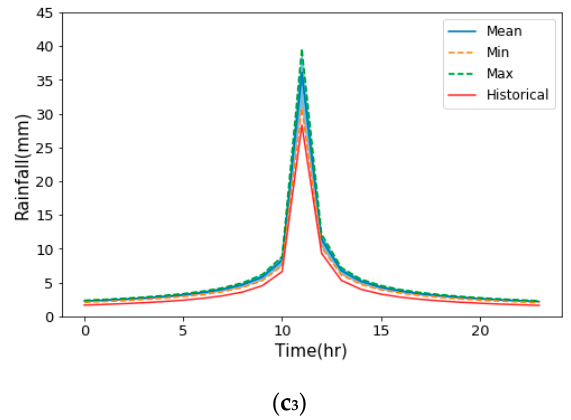
Figure 5. Rainfall hyetographs corresponding to a 25-year event for the historical and future (2050s, RCP4.5) periods. Hyetographs are generated based on ( a 1 ) HUFF, ( b 1 ) SCS, and ( c 1 ) ABM design storm methods for GCM-IDFs, and ( a 2 ) SCS, ( b 2 ) HUFF, ( c 2 ) ABM-1, and ( c 3 ) ABM-2 for WRF-IDFs.